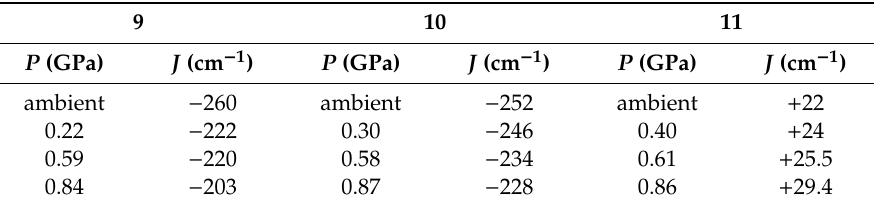
Table 7. Comparison of the J values as a function of pressure for complexes 9–11 , with g = 2.09 for 9 and 10 , and g = 2.11 for 11 .